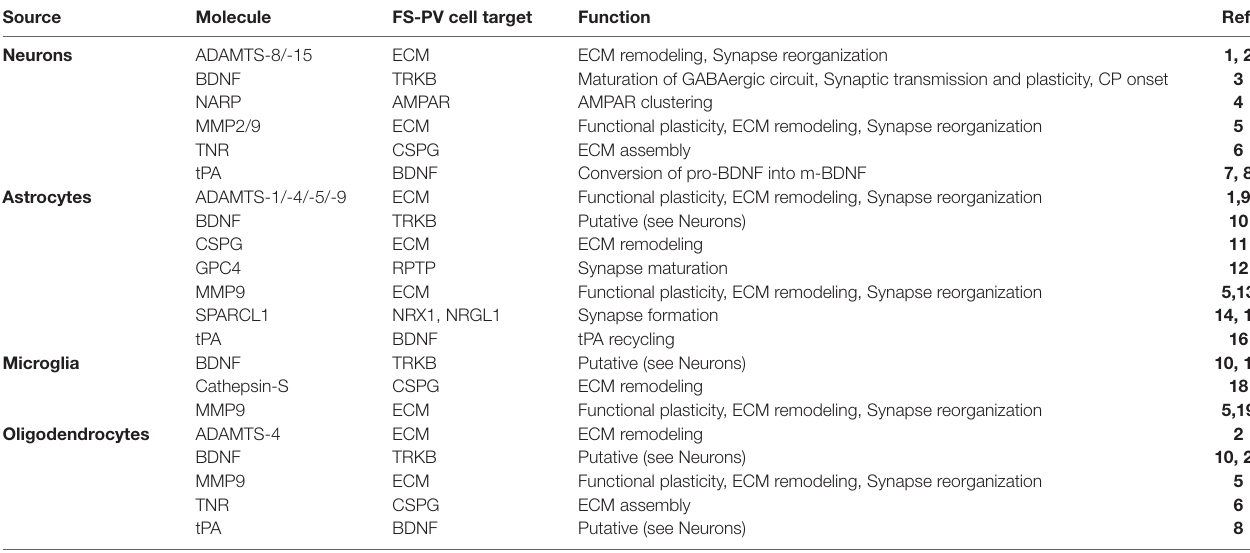
TABLE 1 | Sources, targets, and functions of non-cell-autonomous molecules affecting FS-PV cell activity.